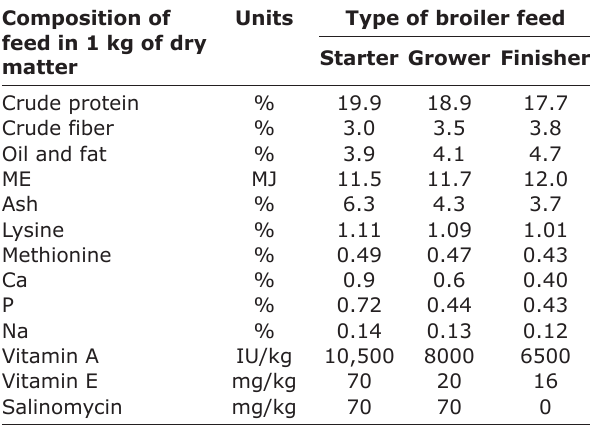
Table-1: Chemical composition of the used broiler diets and additives in the diets. Composition of feed in 1 kg of